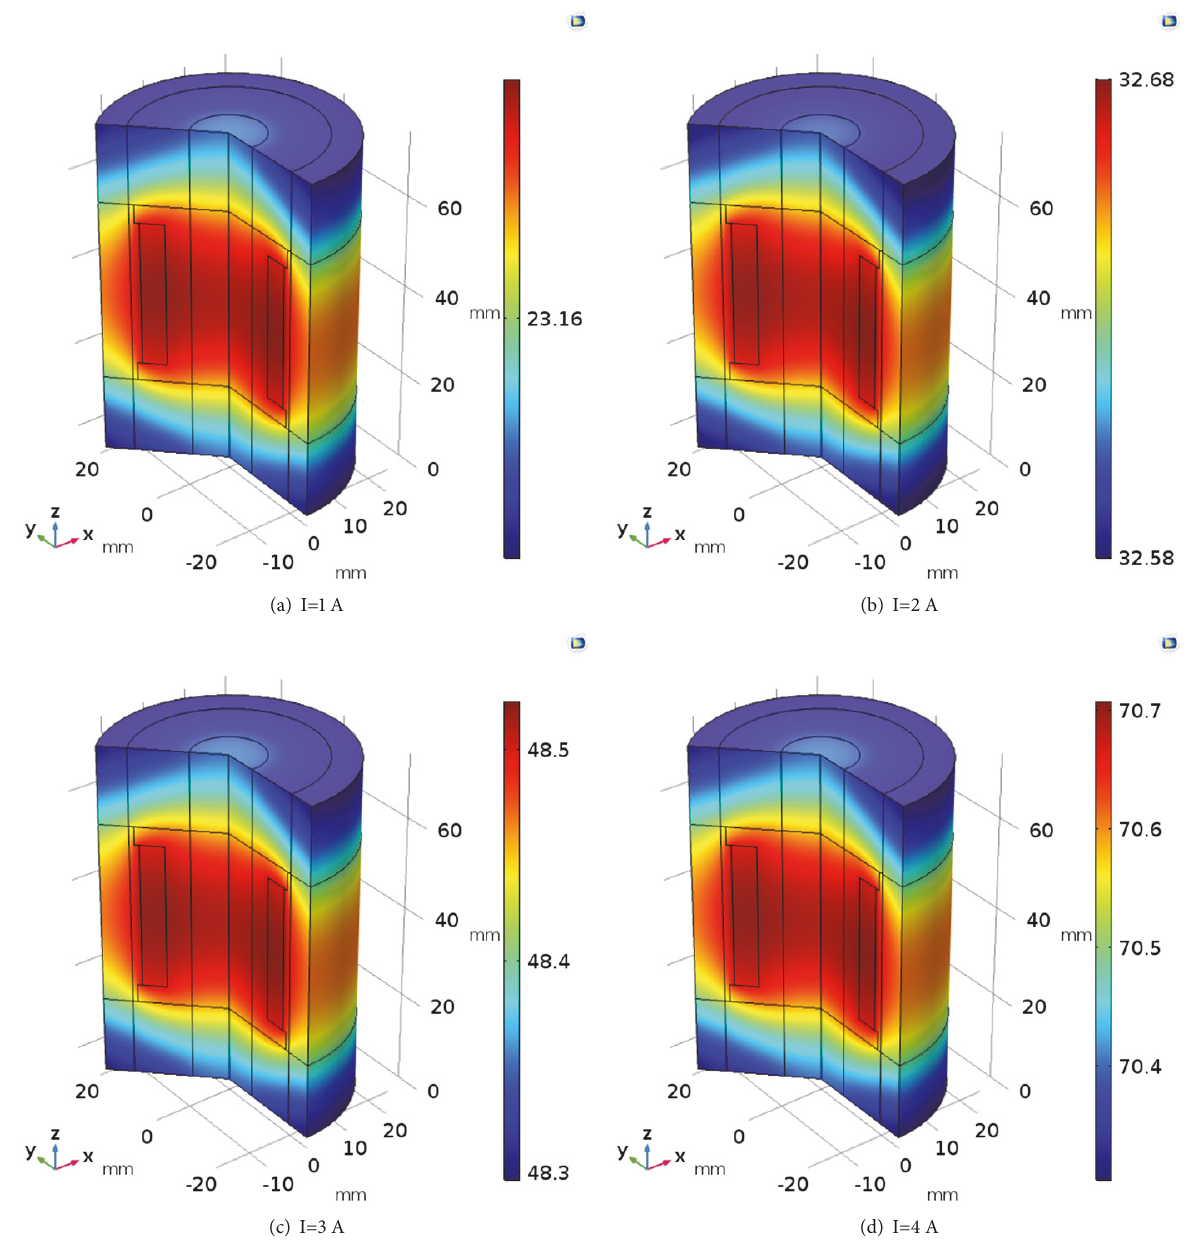
Figure 15: Heat distribution in the MRF